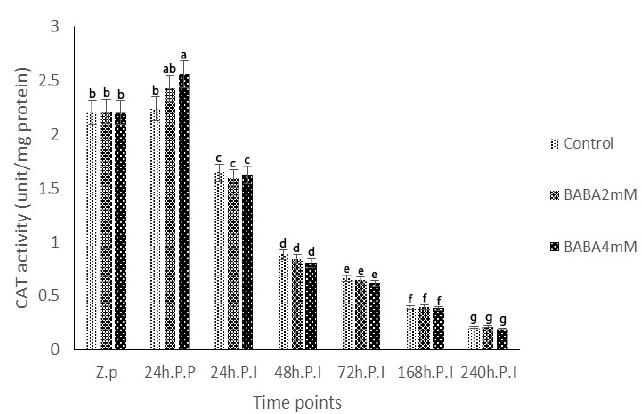
Fig. 7: Effect BABA pretreatments on catalase activity. The mean compari- sons of CAT activity of treated squash plants compared using the Duncan method at a P < 0.01 significance level. Different letters show a significant difference. Z.P; time point 0. 24 PP; 24 h post priming. hpI; hours post inoculation.